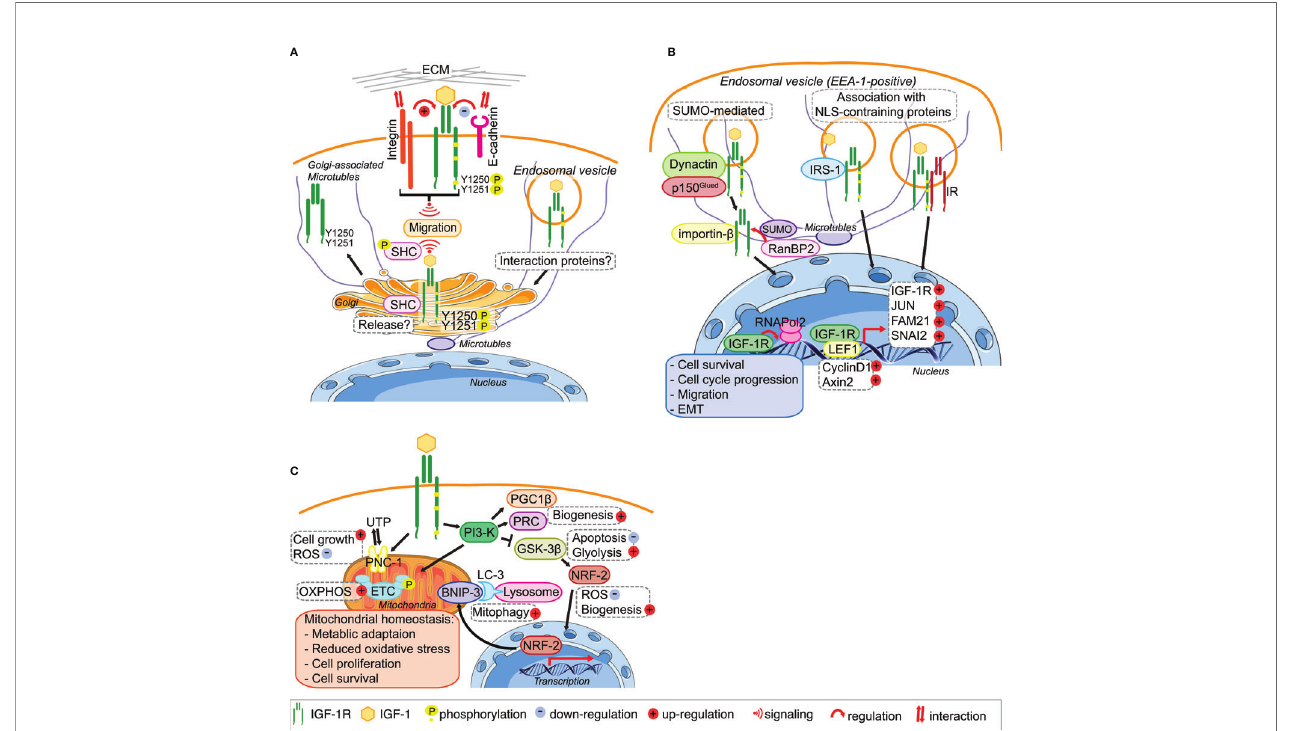
FIGURE 2 | IGF-1R traf fi cking routes and signaling to the mitochondria and from the Golgi and the Nucleus. (A) The IGF-1R translocates to the Golgi apparatus. In migratory cell lines, IGF-1R autophosphorylates Tyr 1250/1251 in an adhesion dependent manner. Phosphorylation of Tyr 1250/1251 IGF-1R leads to rapid IGF-1R endocytosis leads to activation of the MAPK pathway and results in translocation of the IGF-1R to the Golgi which promotes sustained SHC activation to facilitate migration. points. The release and retention of IGF-1R in the Golgi may be regulated by b 1-Integrin and its interaction with the ECM. In cells with low or no migratory capacity, IGF-1R remains on the surface inducing signaling from the membrane. The interaction with other proteins, including E-cadherin, stabilizes the adhesion points and internalization rate of the IGF-1R is low. (B) IGF-1R translocates to the nucleus. IGF-1 binding to the IGF-1R induces the translocation of the membrane receptor to the nucleus. Various mechanisms have been proposed for the import of the IGF-1R to the nucleus. Nuclear IGF-1R can bind to DNA and enhance or initiate the transcription of various genes, leading to cell survival, migration, EMT and cell cycle progression. (C) IGF-1 signaling regulates mitochondrial function. The activation of the PI3-K pathway in response to IGF-1 induces the expression of the mitophagy regulators PGC1 b and PRC. Inhibition of GSK-3 b by PI3-K activation leads to the release of NFE2L2/Nrf2, which translocates to the nucleus to enhance the expression of the mitophagy receptor BNIP-3. Activation of IGF1-R also enhances the expression of the UTP importer PNC-1, which was linked to cell growth and the reduction of ROS. Through these pathways IGF-1 signaling contributes to the maintenance of mitochondrial homeostasis. Figure elements adapted from Servier Medical Art (https://smart.servier.com/), under license